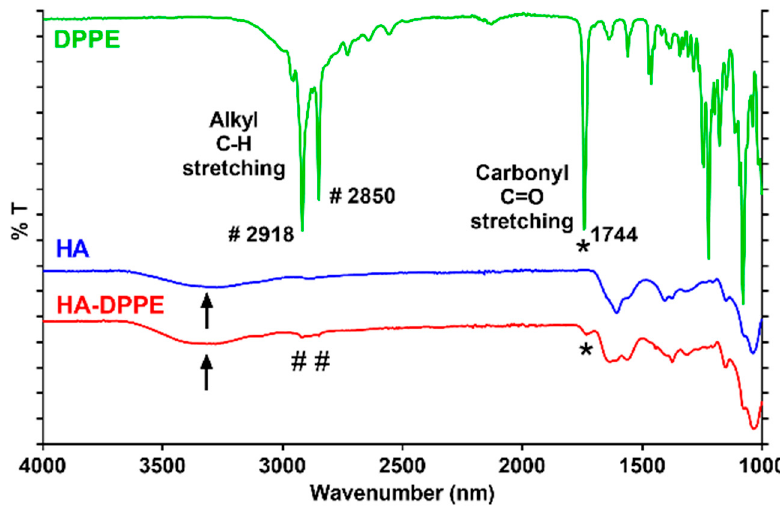
Figure 2. FTIR spectra of DPPE (green line), HA (blue line) and HA-DPPE (red line).